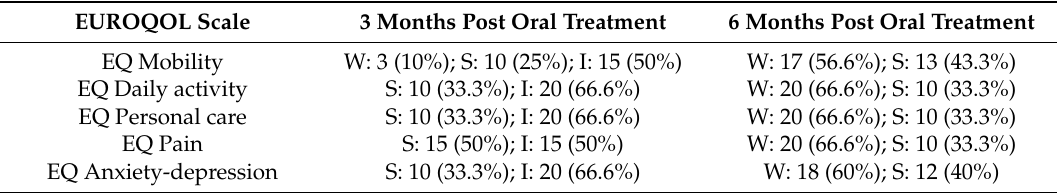
Table 6. EUROQOL Scale Score in patients treated with oral therapies (Control Group). EUROQOL Scale 3 Months Post Oral